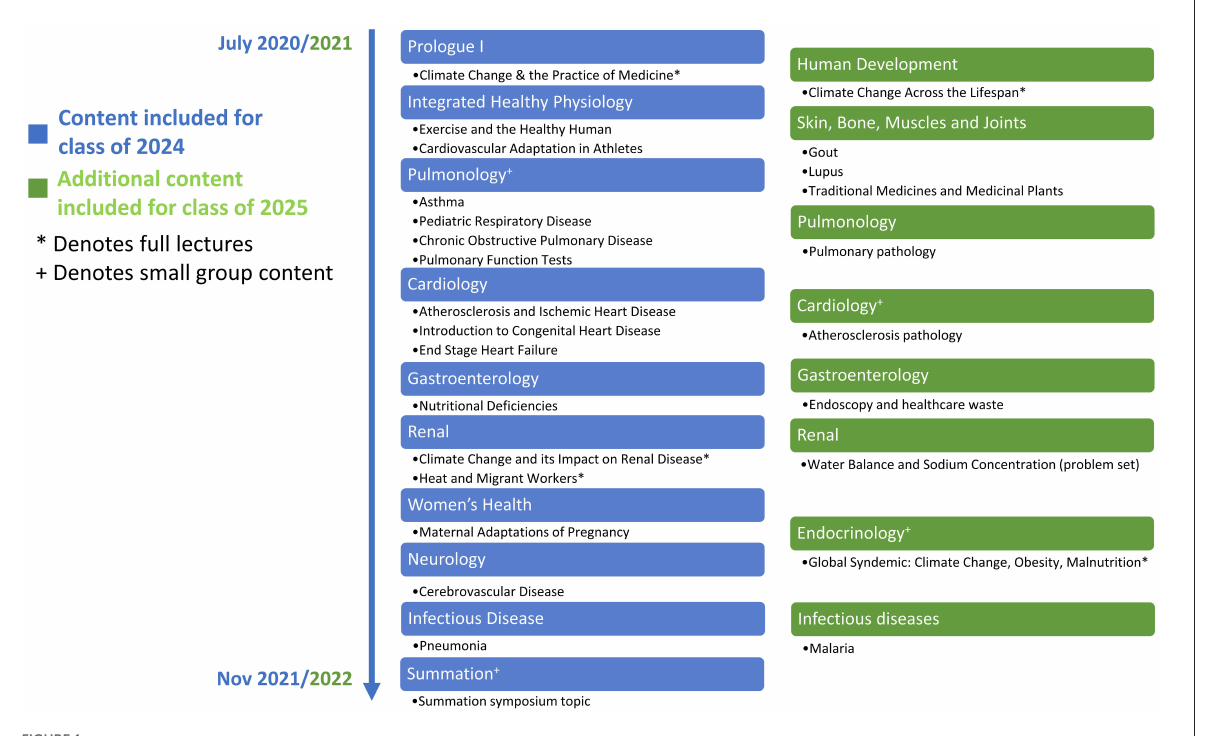
process to identify phrases of meaning in the text,